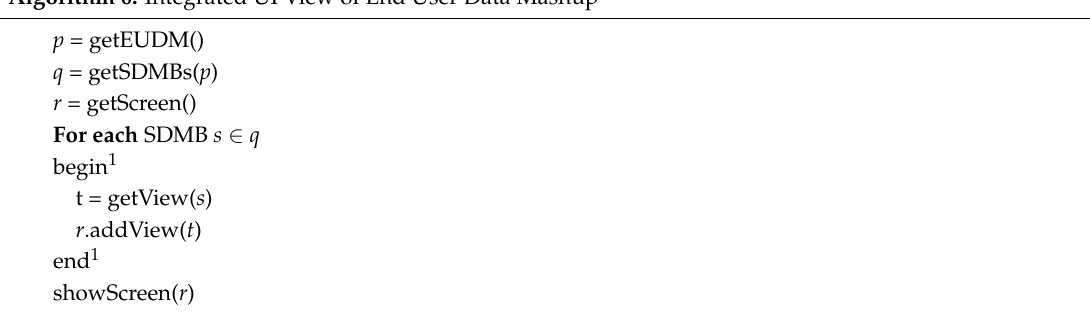
Algorithm 6. Integrated UI View of End User Data